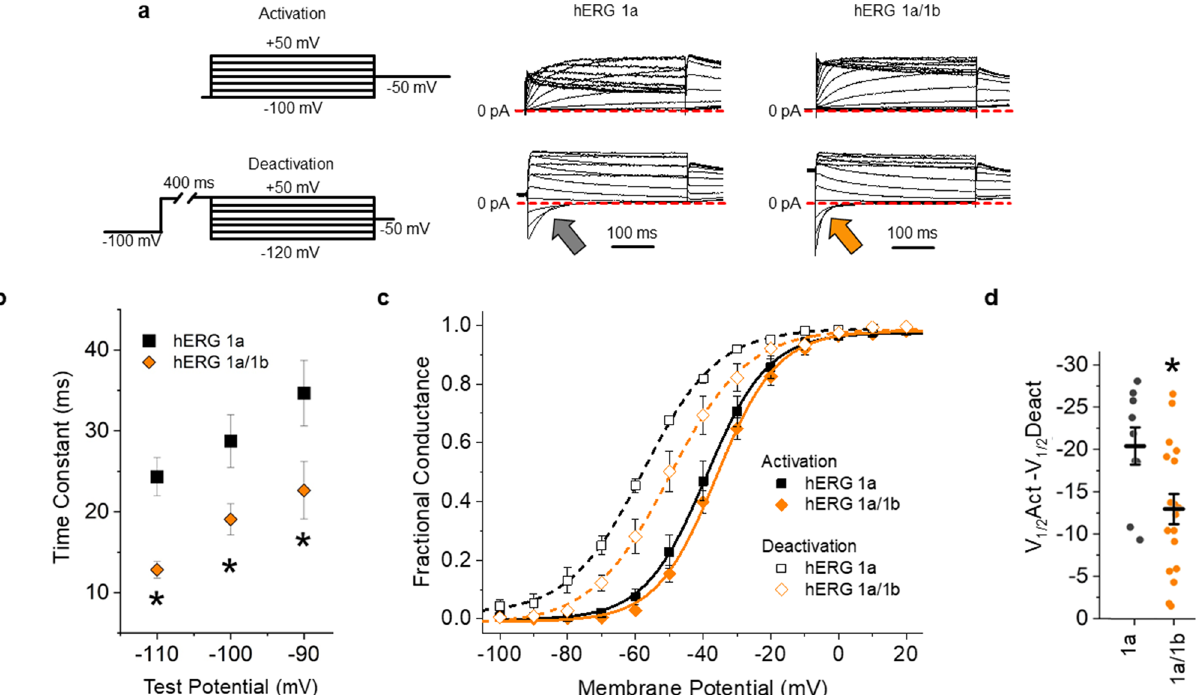
Figure 3. hERG 1b expression reduces hERG channel hysteresis of ionic current. ( a ) Pulse protocol and corresponding sample ionic traces showing hERG 1a (middle) and hERG 1a/1b channel (right) activation when stably expressed in HEK293 cells recorded at physiological temperature (36 °C). ( b ) Pulse protocol and corresponding sample ionic traces showing hERG 1a (middle) and hERG 1a/1b channel (right) deactivation when stably expressed in HEK293 cells recorded at physiological temperature (36 °C). ( c ) hERG 1b modifies hERG channel voltage dependence. Normalized peak tail current, representing fractional conductance, is plotted as a function of pre-pulse potential and fitted with a Boltzmann function for hERG 1a (black) and hERG 1a/1b (orange). Channel activation recorded as in “( a )” is shown with solid symbols. Channel deactivation recorded as in “( a )” is shown with open symbols. ( d ) The magnitude of hysteresis was quantified by subtracting the V 1/2 of deactivation from the V 1/2 of activation. Hysteresis was significantly smaller in hERG 1a/1b heteromeric channels ( n = 10) compared with hERG 1a homomeric channels ( n = 7). All data are reported as mean ± SEM. * indicates p <